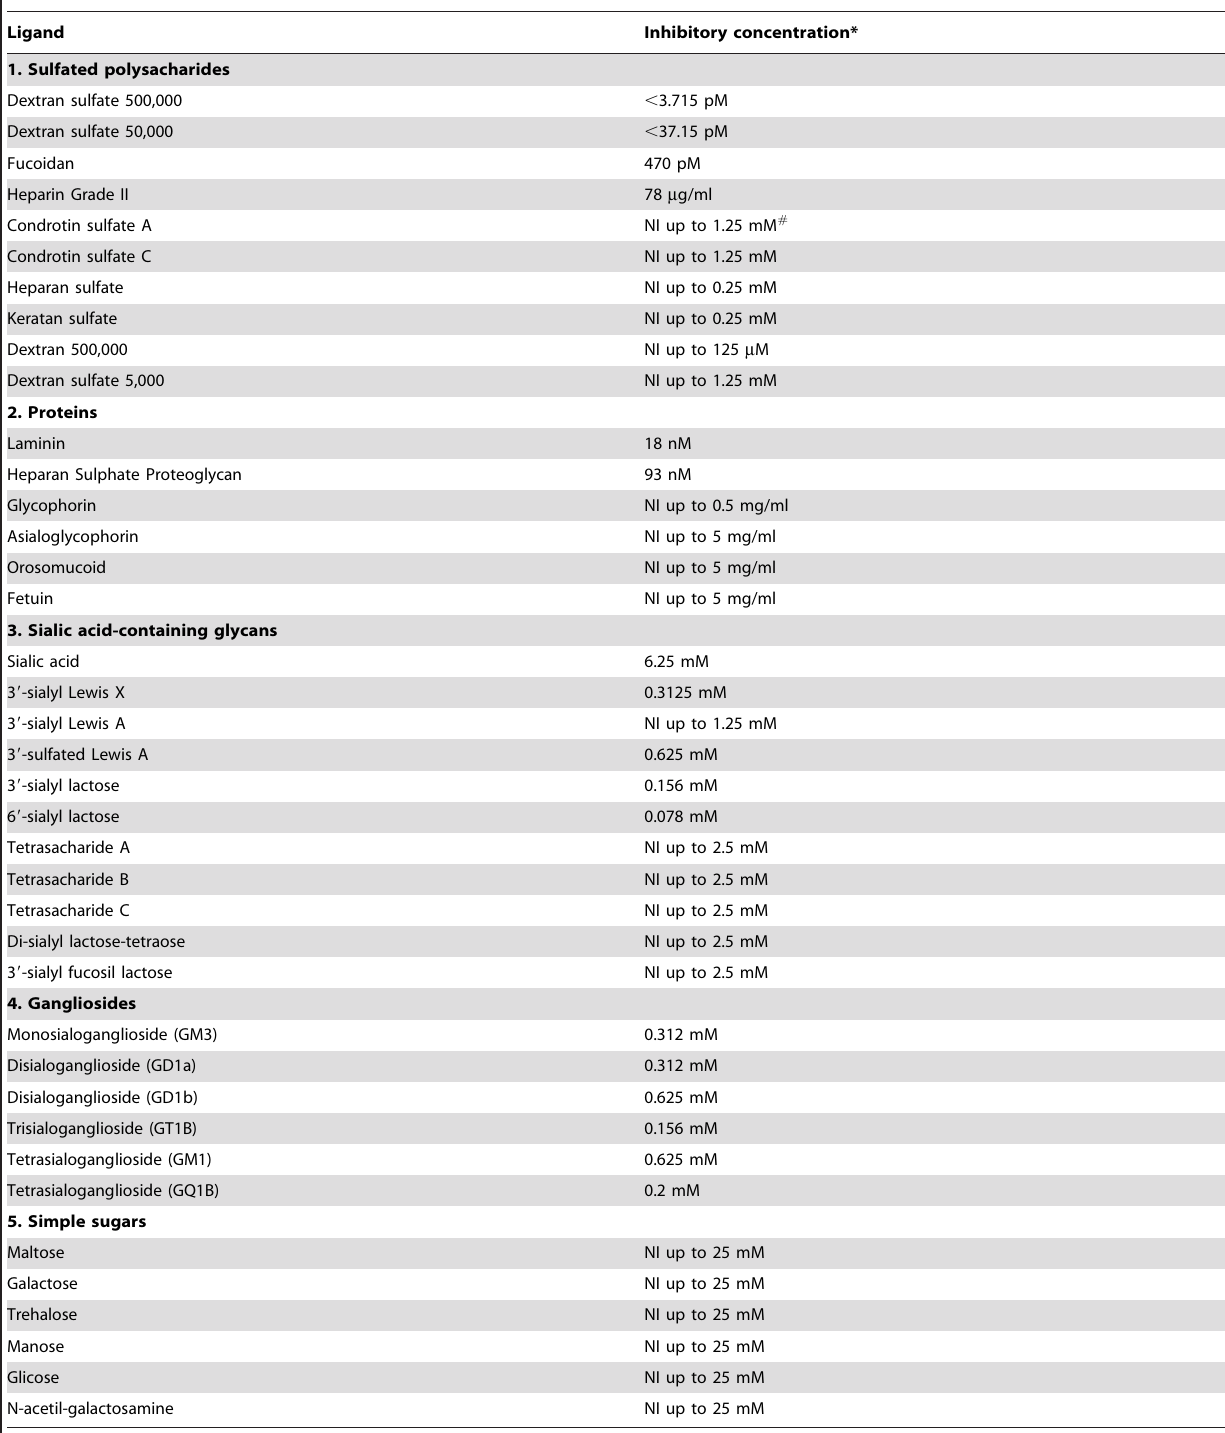
Table 1. Specificity of An. gambiae SGH hemagglutinating activity.